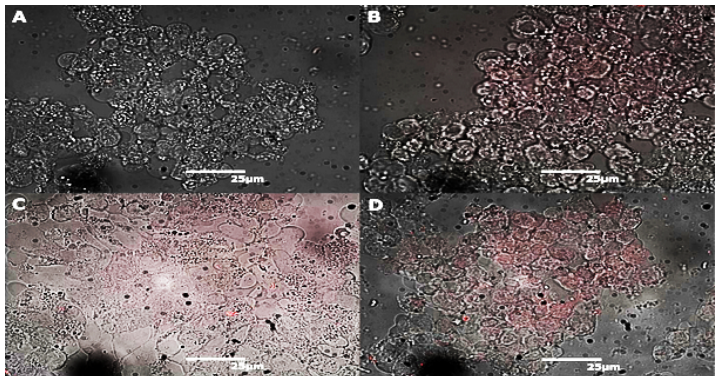
Figure 4. Optical images of CACO-2 cells exposed to alkyl-SiQDs. ( A ) The bright field image shows the morphology of CACO-2 in the control group (0.1% v / v ether), and images ( B – D ) show the morphology of 14 day-treated CACO-2 with SiQDs (0.5, 5, or 50 µ g mL − 1 ) respectively. The fluorescence of the alkyl-SiQDs is overlaid on images ( B – D ) in false color and the brightness and contrast have been